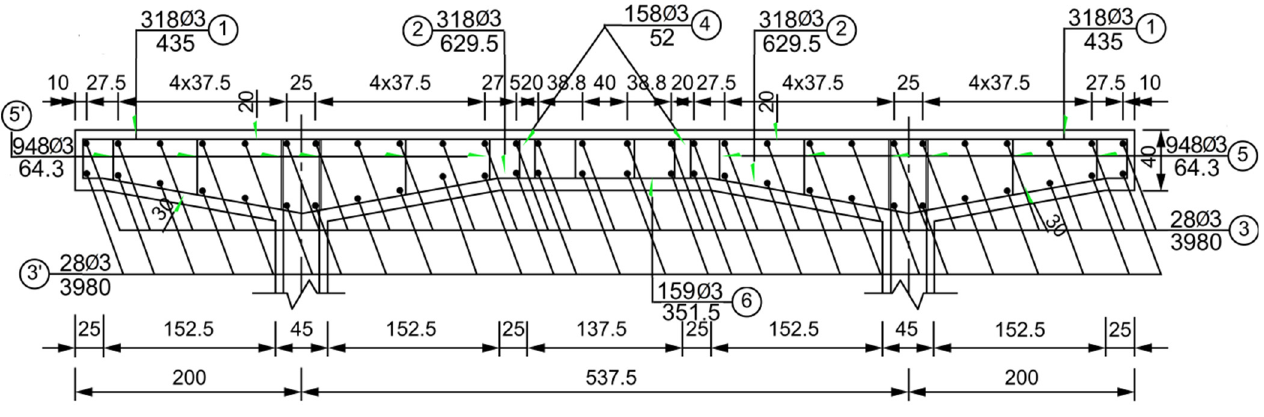
Figure 2. Top view of the test beam.